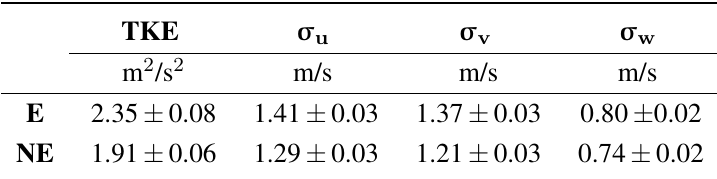
Table 3. Comparison of different average parameters calculated between 09:00 and 16:00 separately for event days and non-event days. The uncertainties are the standard errors. TKE, turbulent kinetic